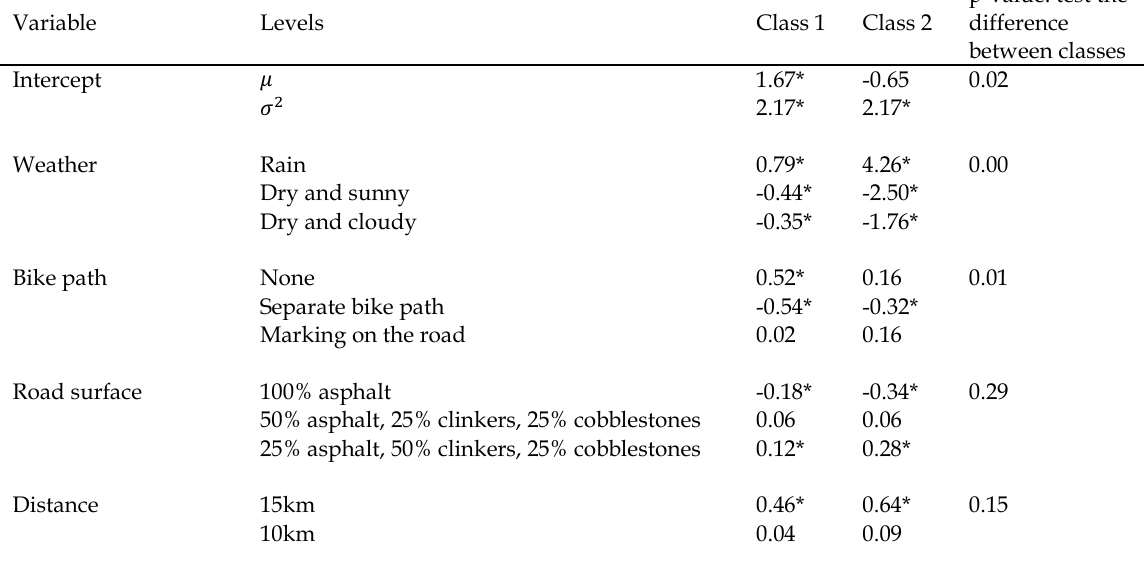
Estimation results for the latent class model with 2 classes and a random